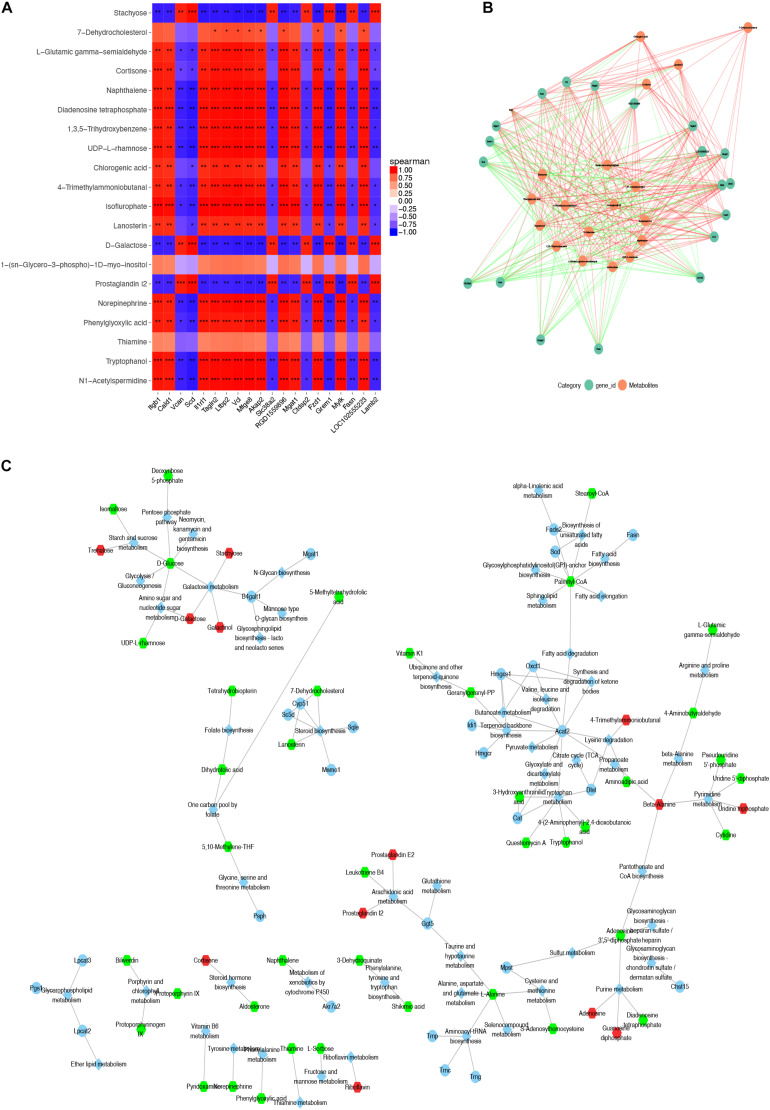
Combined analysis of DEGs and expression of differential metabolites in SASCs and EASCs. (A) A heat map of the top 20 DEGs and differential metabolites in SASCs and EASCs; the horizontal axis represents DEGs, and the vertical represents regulated metabolites. In the figure, red indicates a positive correlation, and blue indicates a negative correlation. The deeper the color, the greater the correlation. (B) The PPI network of the DEGs and differential metabolites. The red line indicates a positive correlation, the green line indicates a negative correlation, and the thickness of the line represents the correlation coefficient. (C) KGML network analysis of DEGs and differential metabolites in SASCs and EASCs. The circles represent genes, hexagons represent metabolites, and diamonds represent pathways. Red indicates upregulated genes or metabolites, and green indicates downregulated genes or metabolites. ***P < 0.001, correlation; **P < 0.01, correlation; *P < 0.05, correlation.